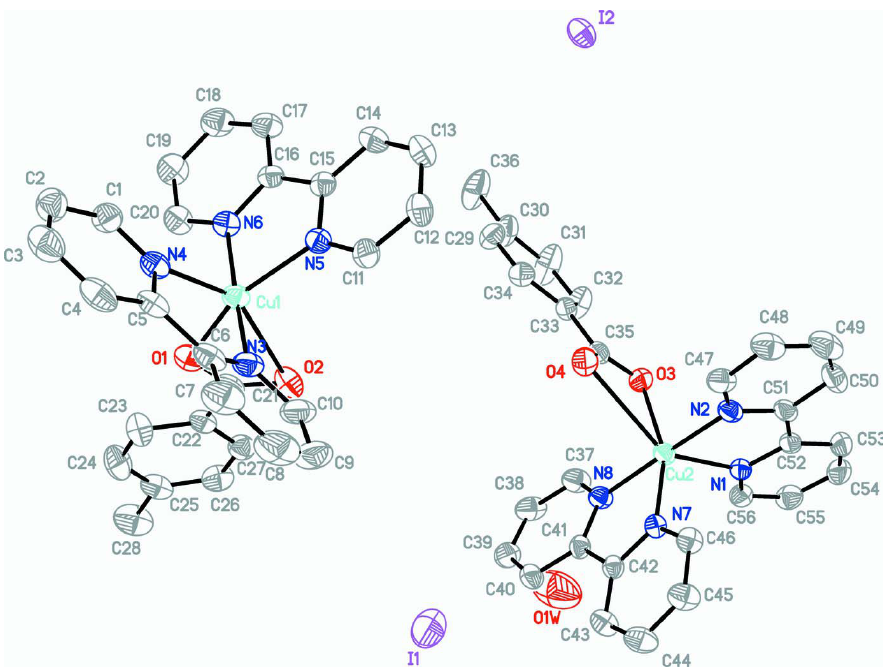
Figure 1 The molecular structure of the title compound. Displacement ellipsoids are drawn at the 30% probability level. H atoms have been omitted for